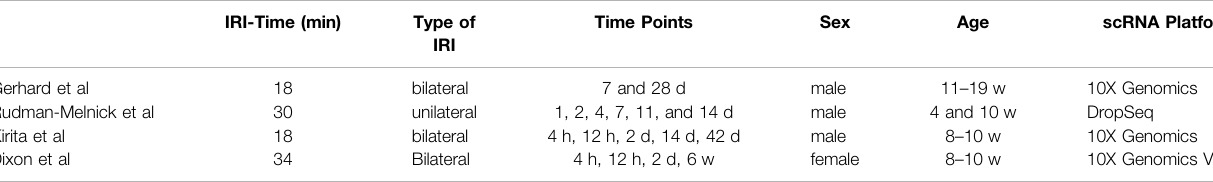
TABLE 1 | IRI and scRNA seq